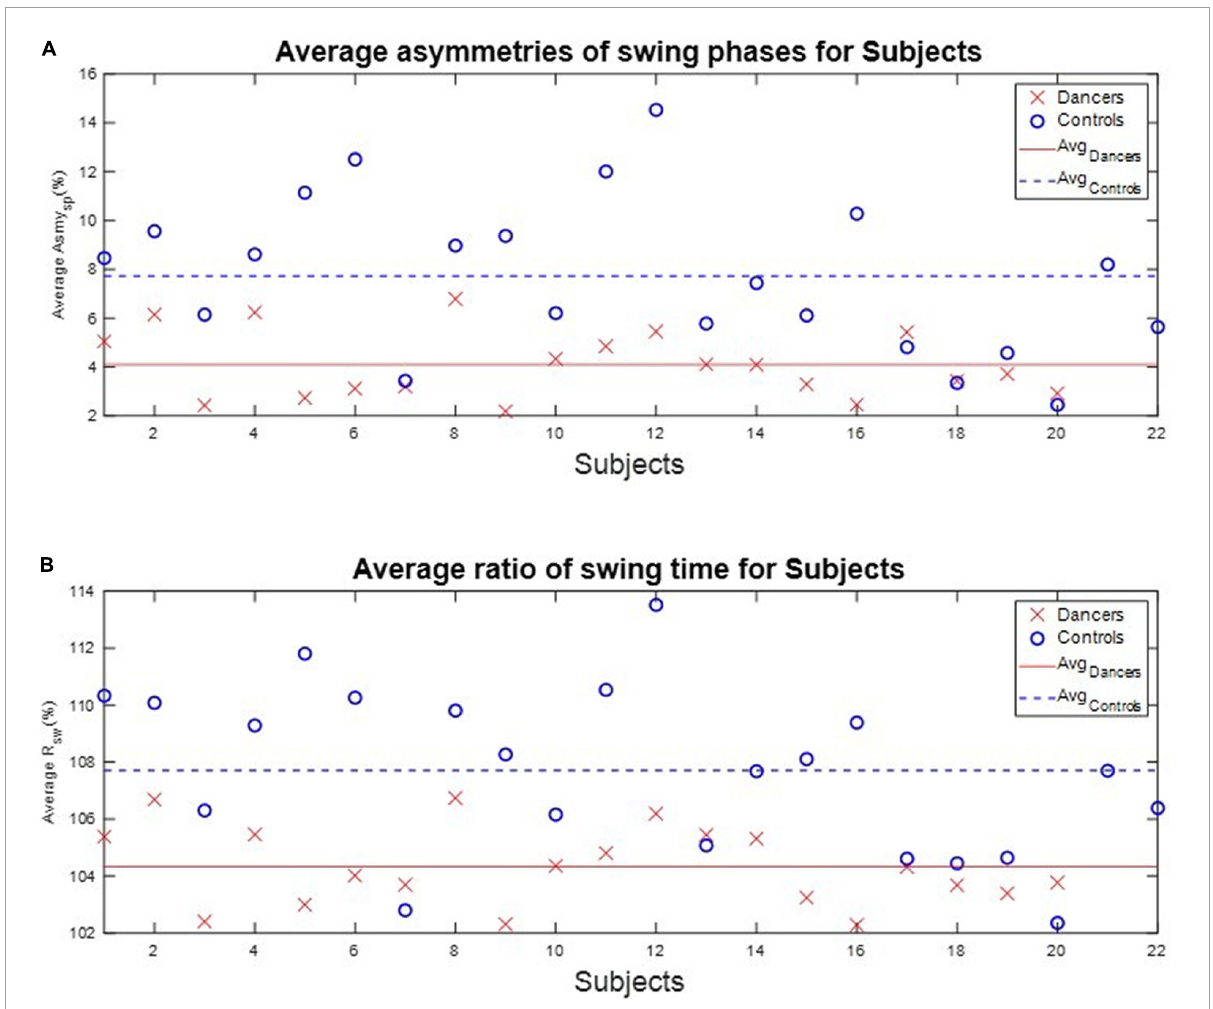
FIGURE7 The average Asym SP and R SW of subjects. The average Asym SP of the dancers ranged between 2.19% (D9) and 6.79% (D8), while the average Asym SP of the non-dancer controls ranged between 2.45% (N20) and 14.53 (N12). The average R SW of dancers ranged between 102.29% (D16) and 106.74% (D8), while the average R SW of healthy controls ranged between 102.35% (N20) and 113.52% (N12). The dancers tended to have better gait symmetry than the non-dancer controls. (A) The average asymmetry of the swing phases Asym SP of each subject. (B) The average ratio of swing time R SW of each